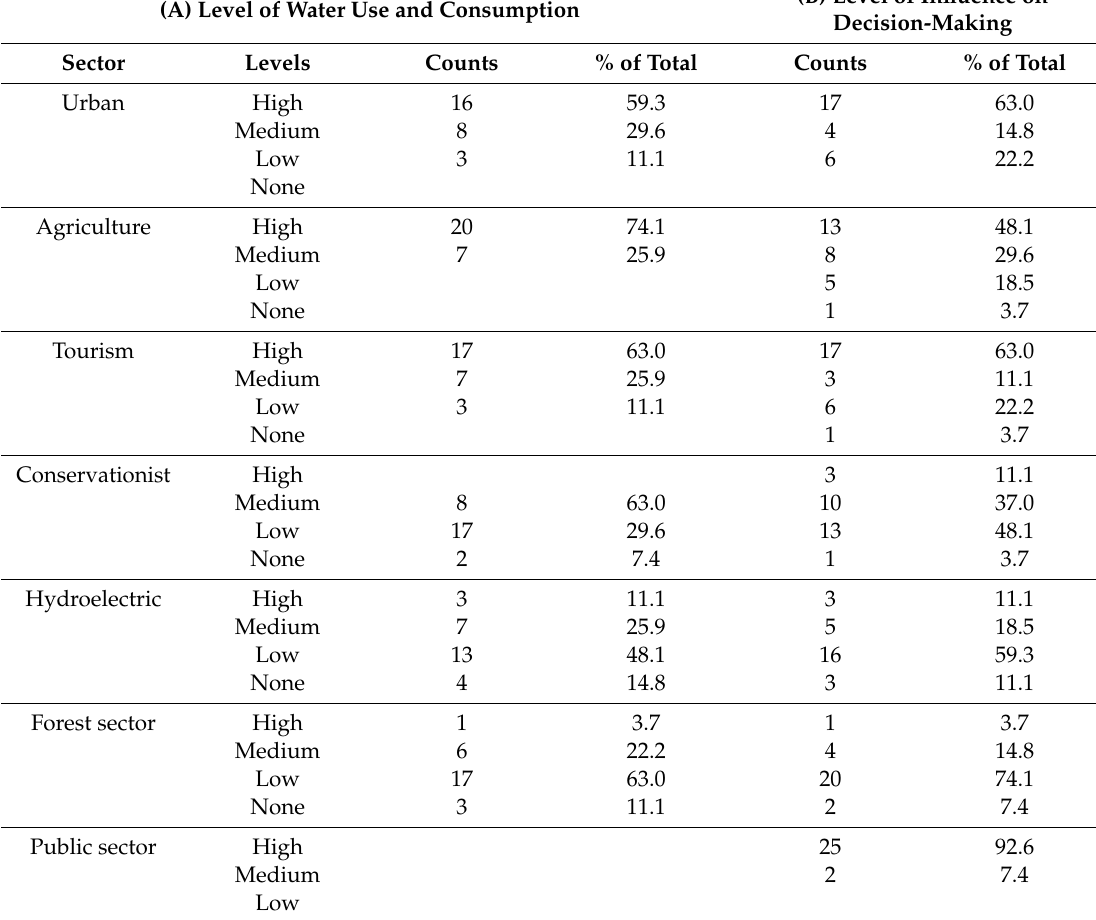
Table A3. Comparison between level of water use and consumption by stakeholder sectors ( A ) and their level of influence on decision-making ( B ) according to stakeholder